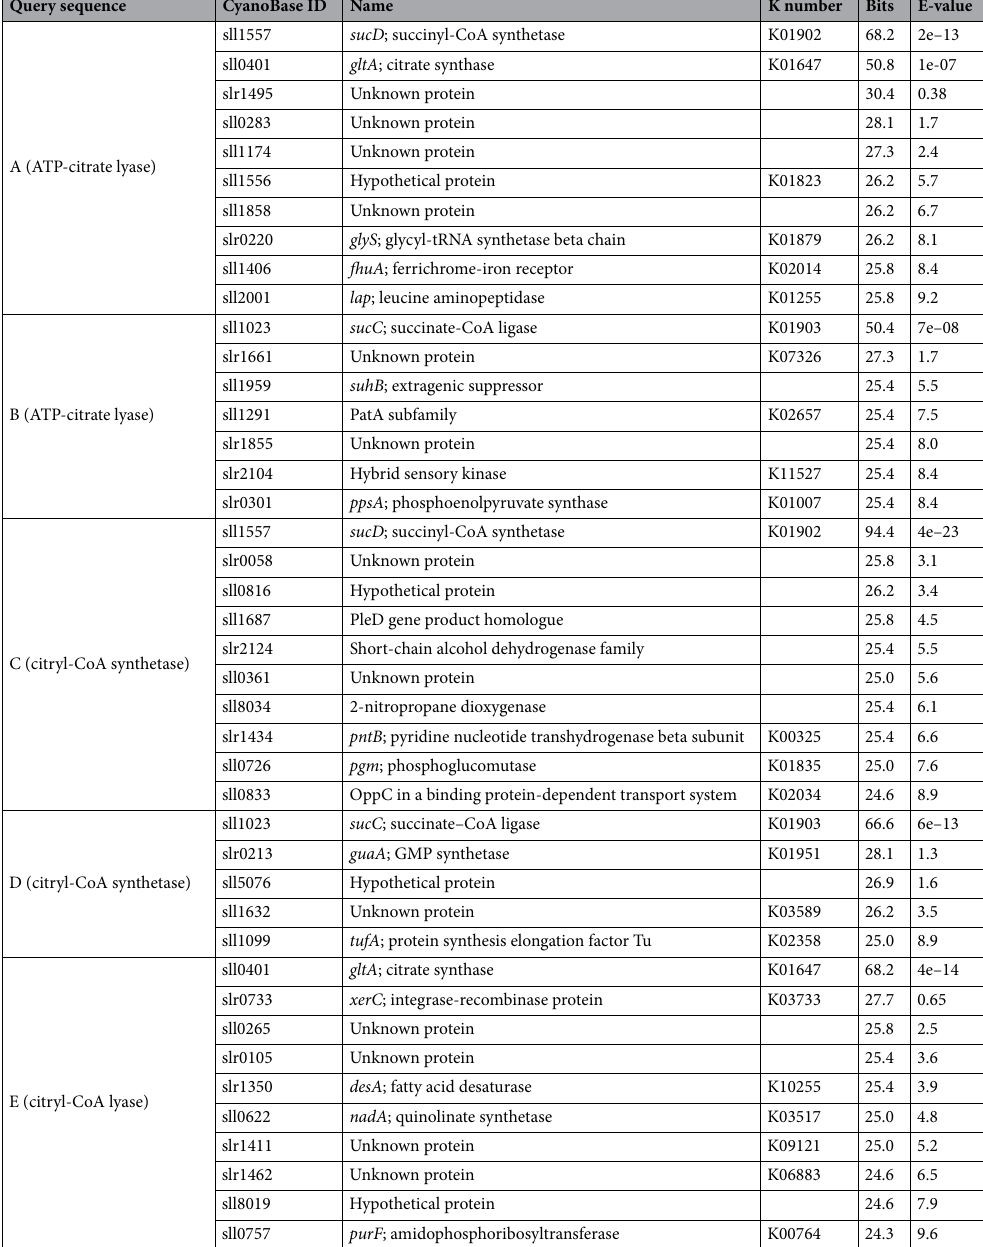
Table 1. BLAST search results for ATP-citrate lyase, citryl-CoA synthetase, and citryl-CoA lyase. BLAST search for ATP-citrate lyase, citryl-CoA synthetase, and citryl-CoA lyase was performed using the Kyoto Encyclopedia of Genes and Genomes database (https:// www. genome. jp/ kegg/ genome. html). The following sequences were used for the search: A: ATP-citrate lyase alpha-subunit from Chlorobium limicola